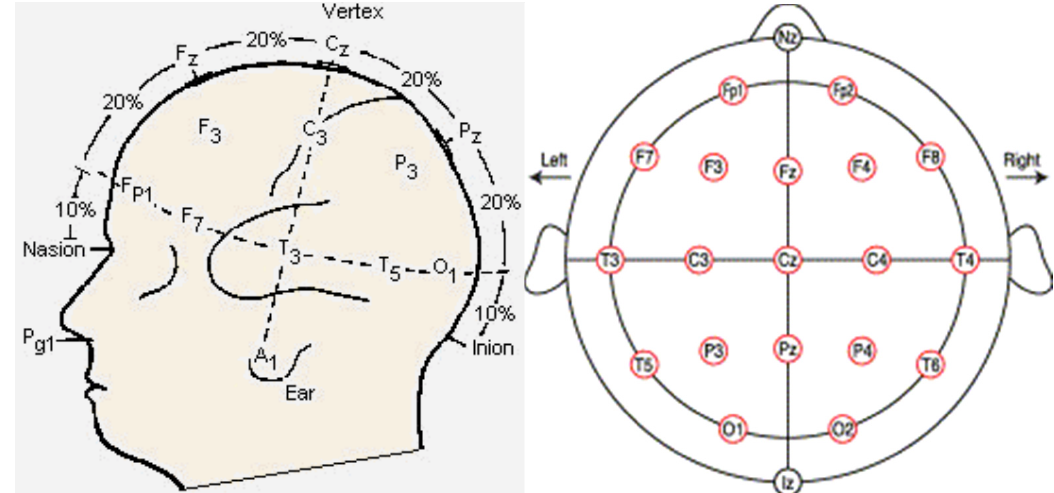
Figure 1. Names and positions of the international 10–20 system used in this study. Nineteen standard positions in the conventional 10–20 system are shown (red circles) [38].